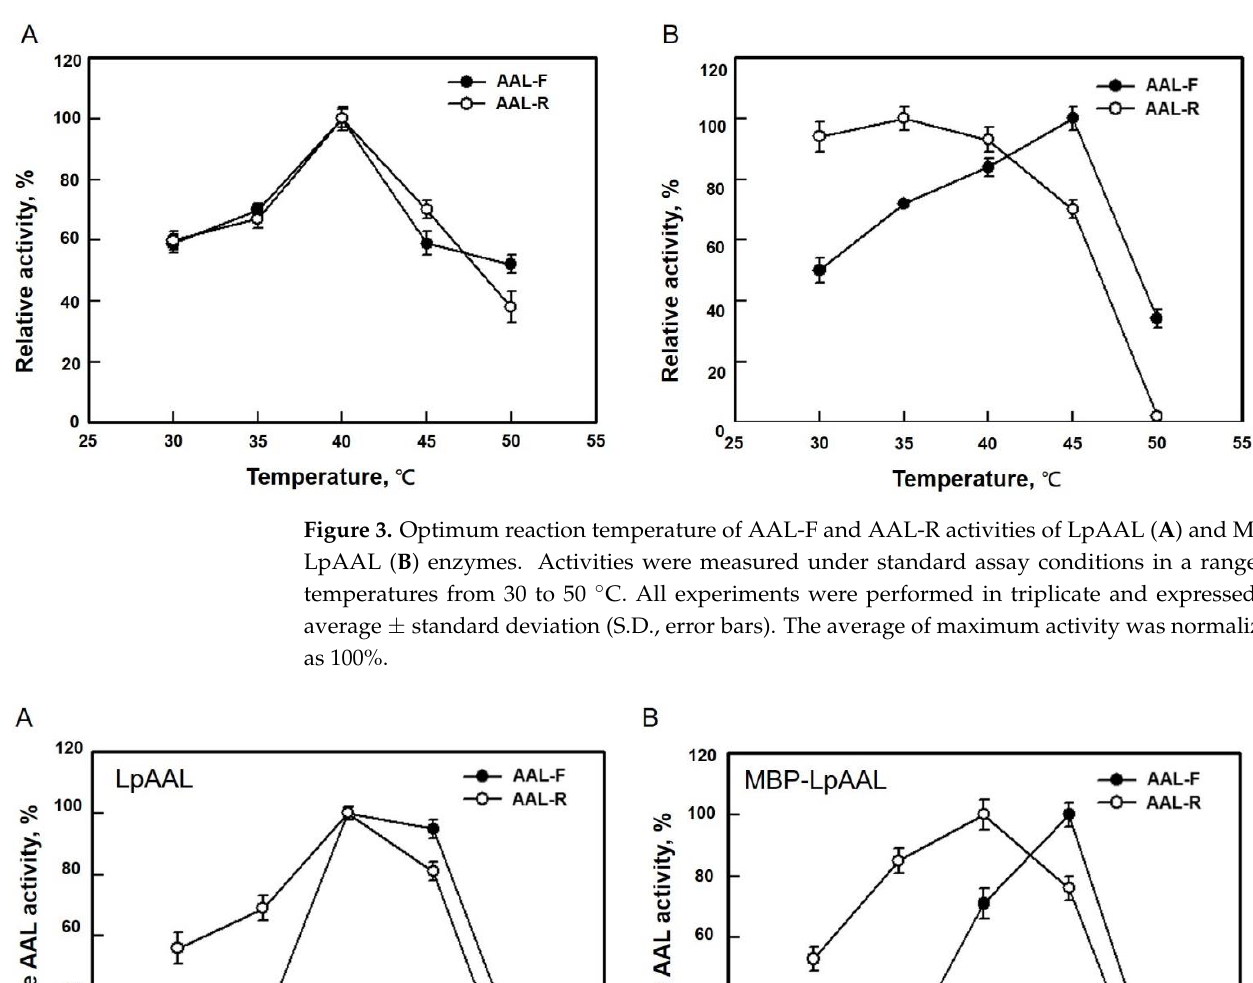
Figure 3. Optimum reaction temperature of AAL-F and AAL-R activities of LpAAL ( A ) and MBP- LpAAL ( B ) enzymes. Activities were measured under standard assay conditions in a range of tem- peratures from 30 to 50 °C. All experiments were performed in triplicate and expressed as average ± standard deviation (S.D., error bars). The average of maximum activity was normalized as 100%.